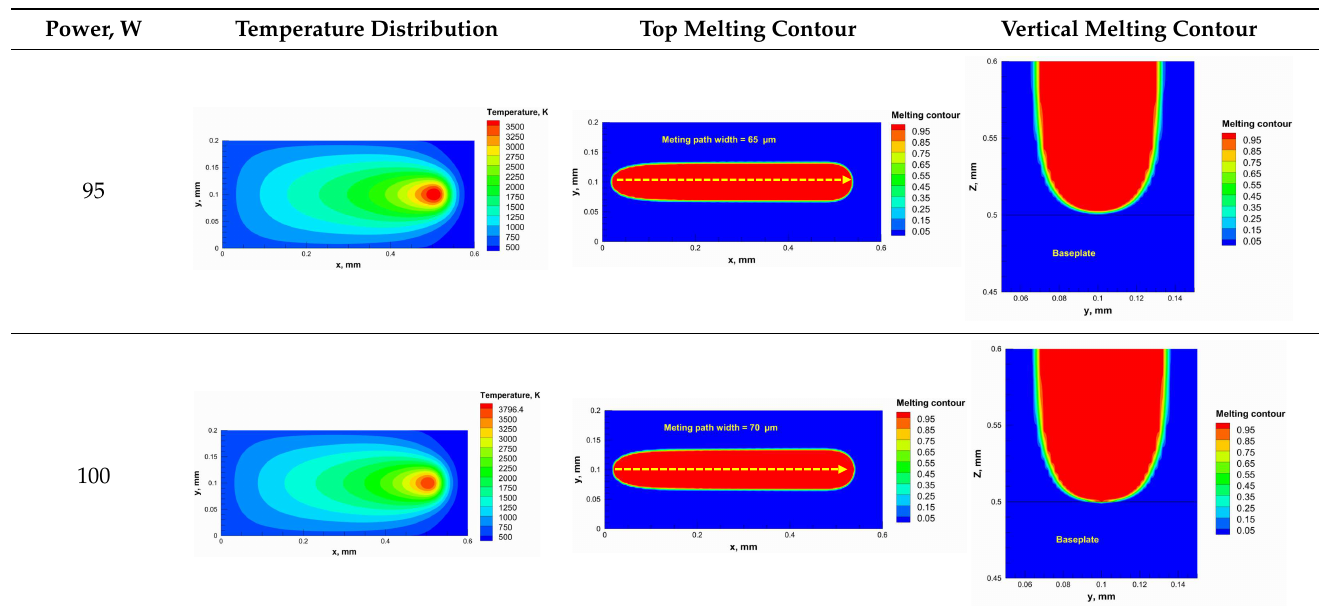
Table 5. Temperature distribution and melting contour obtained from the numerical model (Nd-YAG).